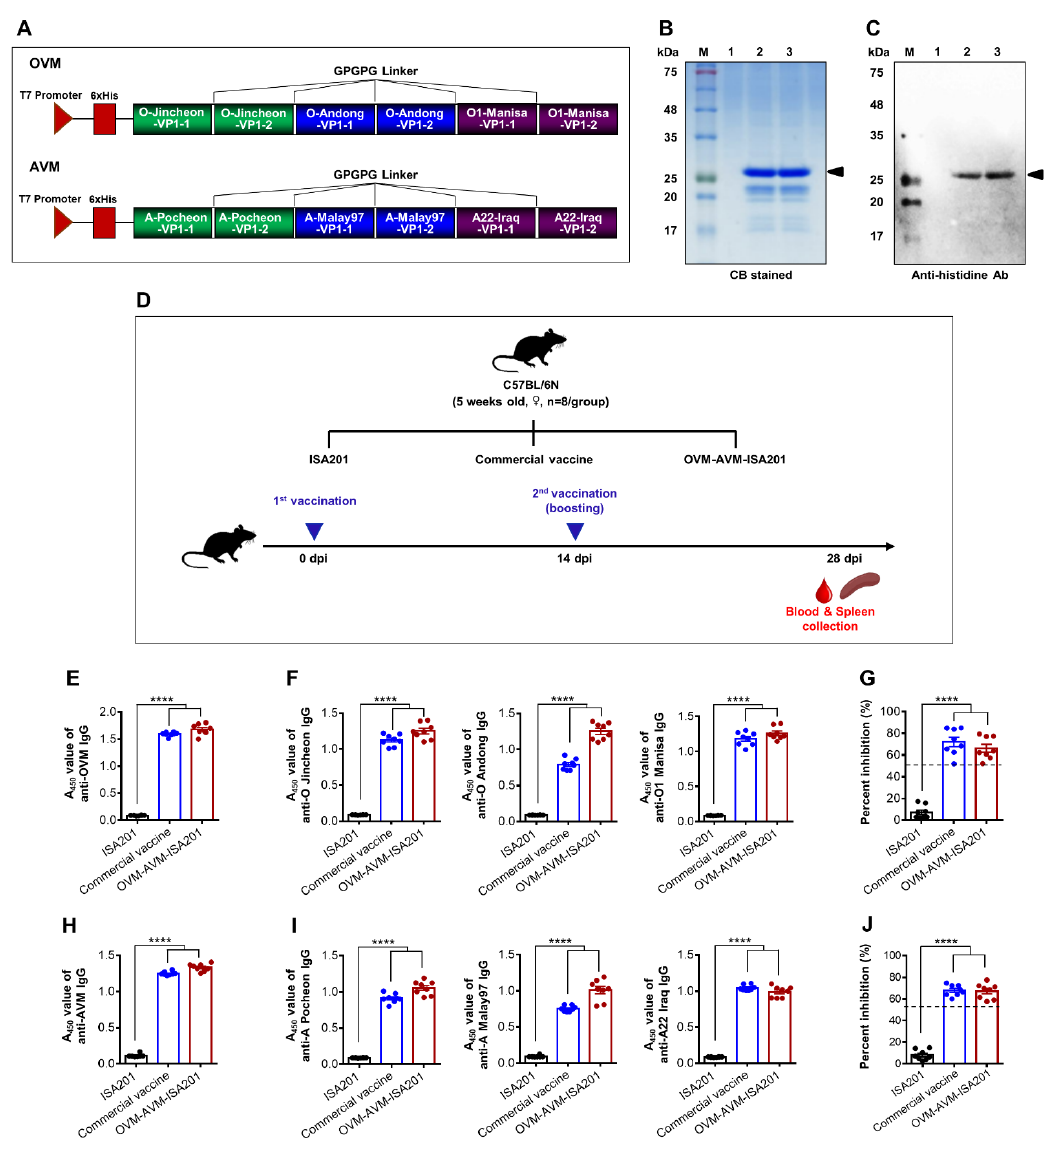
Figure 1. Schematic representation of the recombinant OVM and AVM constructs, purification and expression of OVM and AVM antigens, and OVM-AVM-ISA201-mediated humoral immune re- sponses in mice. ( A ) Schematic depiction of the recombinant pHis parallel-OVM protein expression vector system. ( B ) SDS-PAGE of purified protein. Lanes: M, protein marker; 1, PBS; 2, purified OVM protein; 3, purified AVM protein (CB: Coomassie Blue). ( C ) Confirmation of OVM and AVM protein by Western blot analysis with the mouse anti-His monoclonal antibody. Lanes: M, protein marker; 1, PBS; 2, purified OVM protein; 3, purified AVM protein. C57BL/6 mice were divided into 3 groups ( n = 8/group) and intramuscularly administered with 20 µg of OVM and 20 µg of AVM emulsified with ISA201. The positive control received (1/10 pig dose) commercial trivalent vaccine. The nega- tive control received the same volume of ISA201. Immunization was performed twice at 0 and 14 days. Blood samples were collected for serological assays at 28 days post immunization (dpi). ( D )